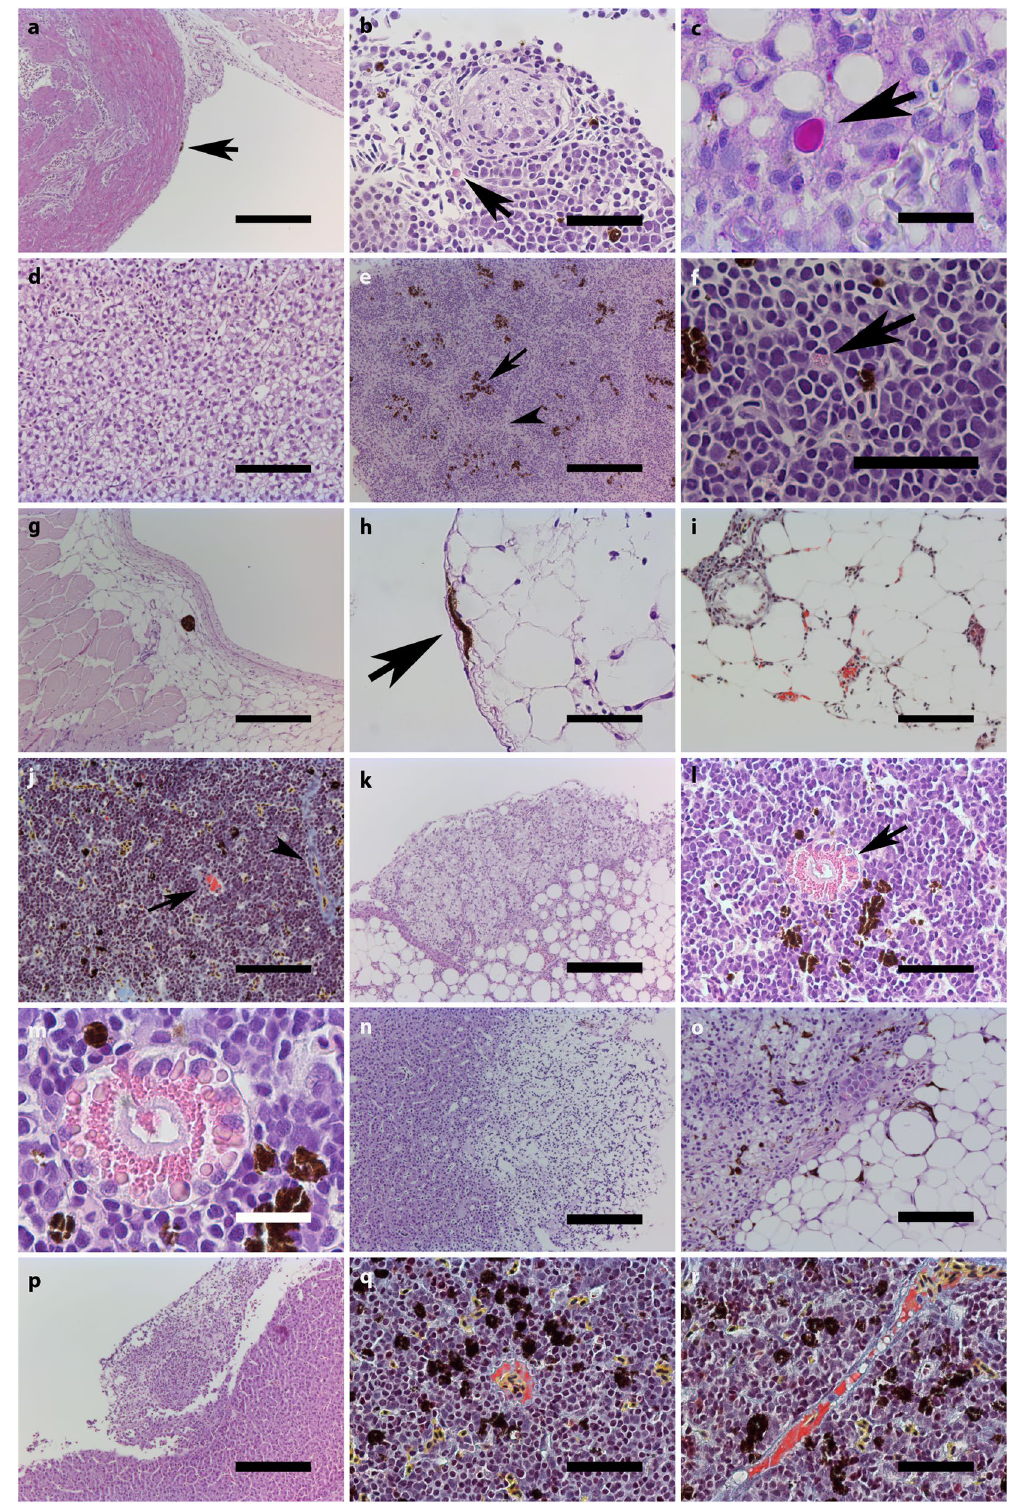
Figure 4. Histological examination of sampled tissues. Unless otherwise stated, samples are HE-stained. ( a ) Melanomacrophage(s) in bulbus arteriosus, FIA group, three weeks post vaccination (3 wpv). Scalebar (sb) = 200 µ m. ( b ) Mott cell in anterior kidney, control group, 3 wpv. Sb = 100 µ m. ( c ) Mott cell in liver, PAS stained, 10 wpv. Sb = 20 µ m. ( d ) Hepatocellular vacuolization, 3 wpv. Sb = 100 µ m. ( e ) Clear distinction between red (arrowhead) and white (arrow) splenic pulps with melanomacrophages in white pulp, CpG group, 10 wpv. Sb = 200 µ m). ( f ) Eosinophilic granule cell in anterior kidney, FIA group, 10 wpv. Sb = 50 µ m. ( g ) Melanomacrophage(s) in extraperitoneal adipose tissue, TBS group, 10 wpv. Sb = 200 µ m. ( h ) Melanomacrophages in intraperitoneal adipose tissue, bacterin group, 3 wpv. Sb = 50 µ m. ( i ) Fibrin